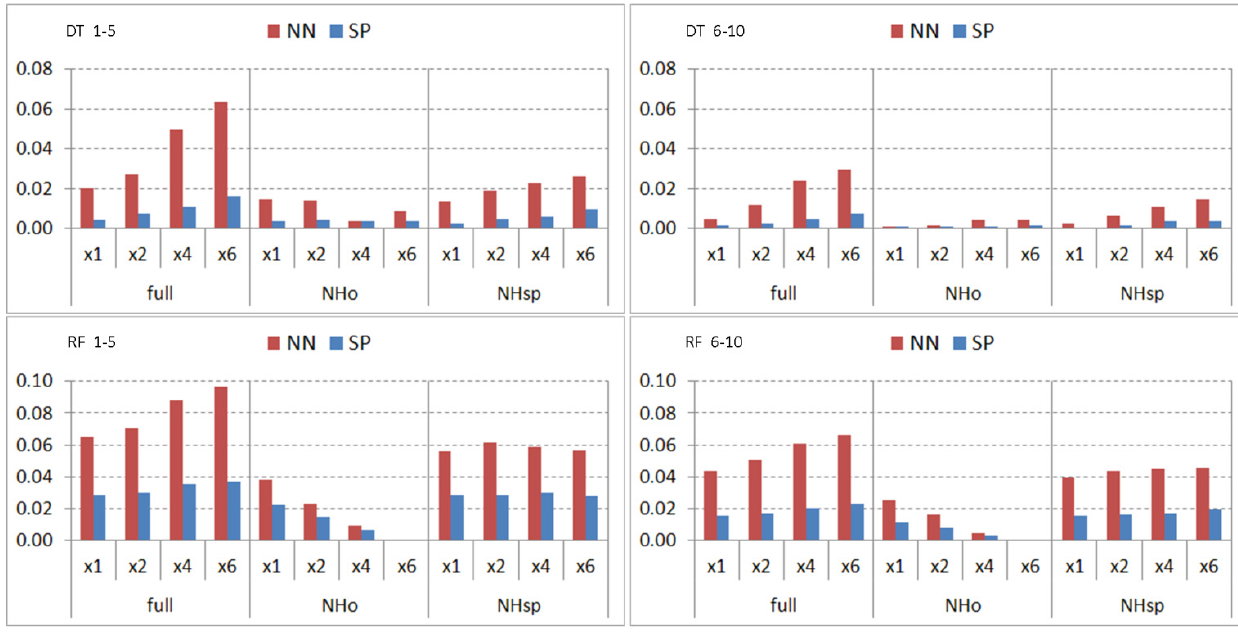
) and superpixel-based (NH o and SP i i